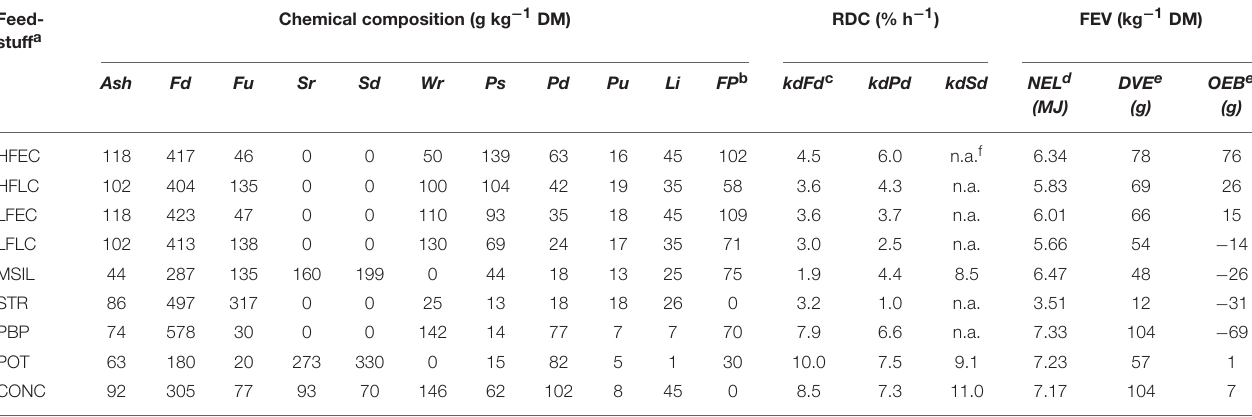
TABLE 2 | Chemical composition, rumen degradation characteristics (RDC), and feed evaluation values (FEV) of the feedstuffs used. Feed- stuff